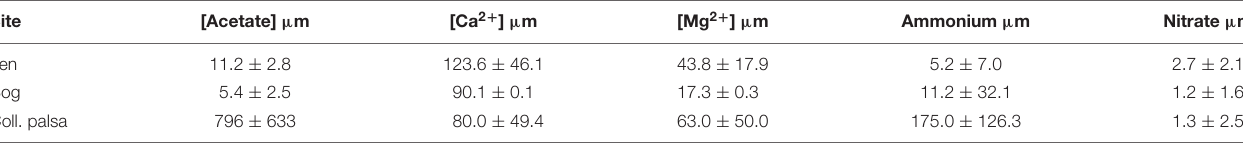
TABLE 2 | Acetate and nutrient concentrations in porewater from Hodgkins